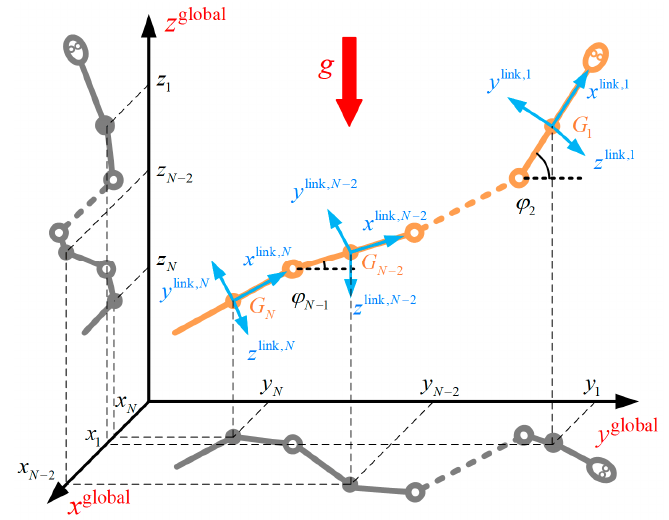
Figure 2. The Multi-link model of the snake-like robot.